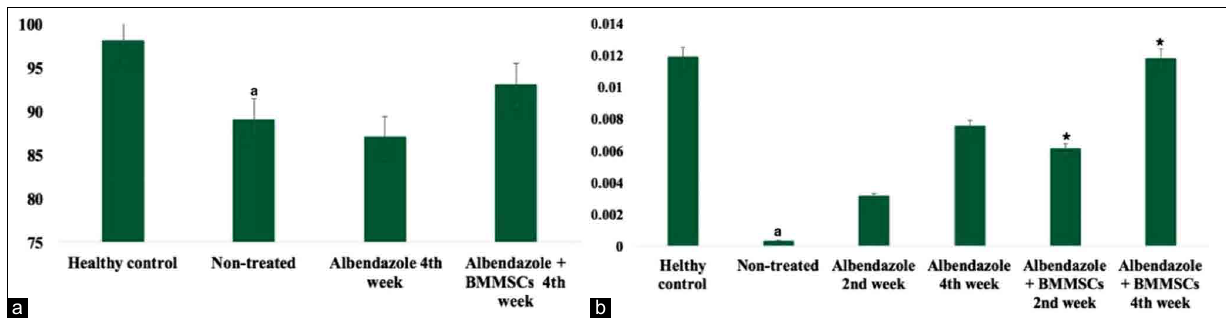
a Figure-12: (a) Spleen lymphocytes viability % and (b) phagocytic index of different infected and treated groups. a Significantly different relative to healthy control at p<0.01. *Significantly different relative to untreated at p<0.05. BMMSCs=Bone marrow mesenchymal stem cells. Table-6: Serum cytokines profile of healthy control, treated and untreated T. vitulorum -rat models (ng/mL). Parameters Healthy T. vitulorum-rat models control Untreated Albendazole Albendazole with BMMSCs